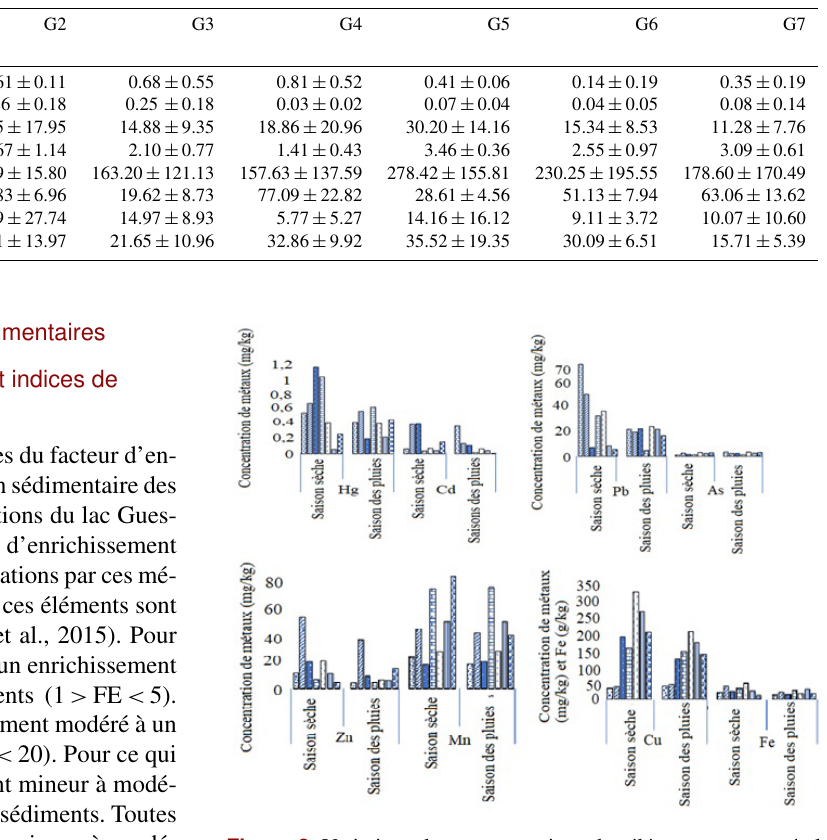
Figure 2. Variations des concentrations des éléments traces métal- liques dans les sédiments du lac